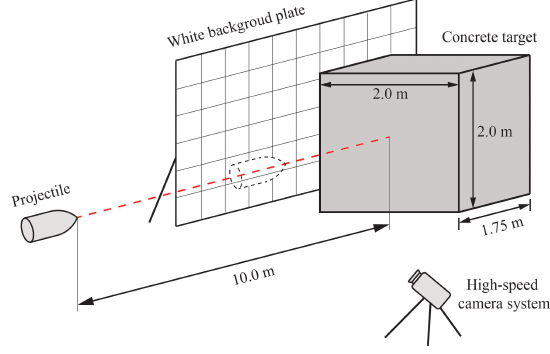
Figure 1. Plan sketch of experiment layout.